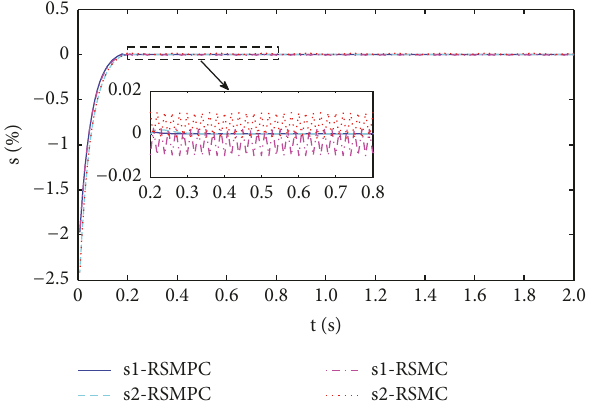
Figure 5: Evolution of control input with different controllers.